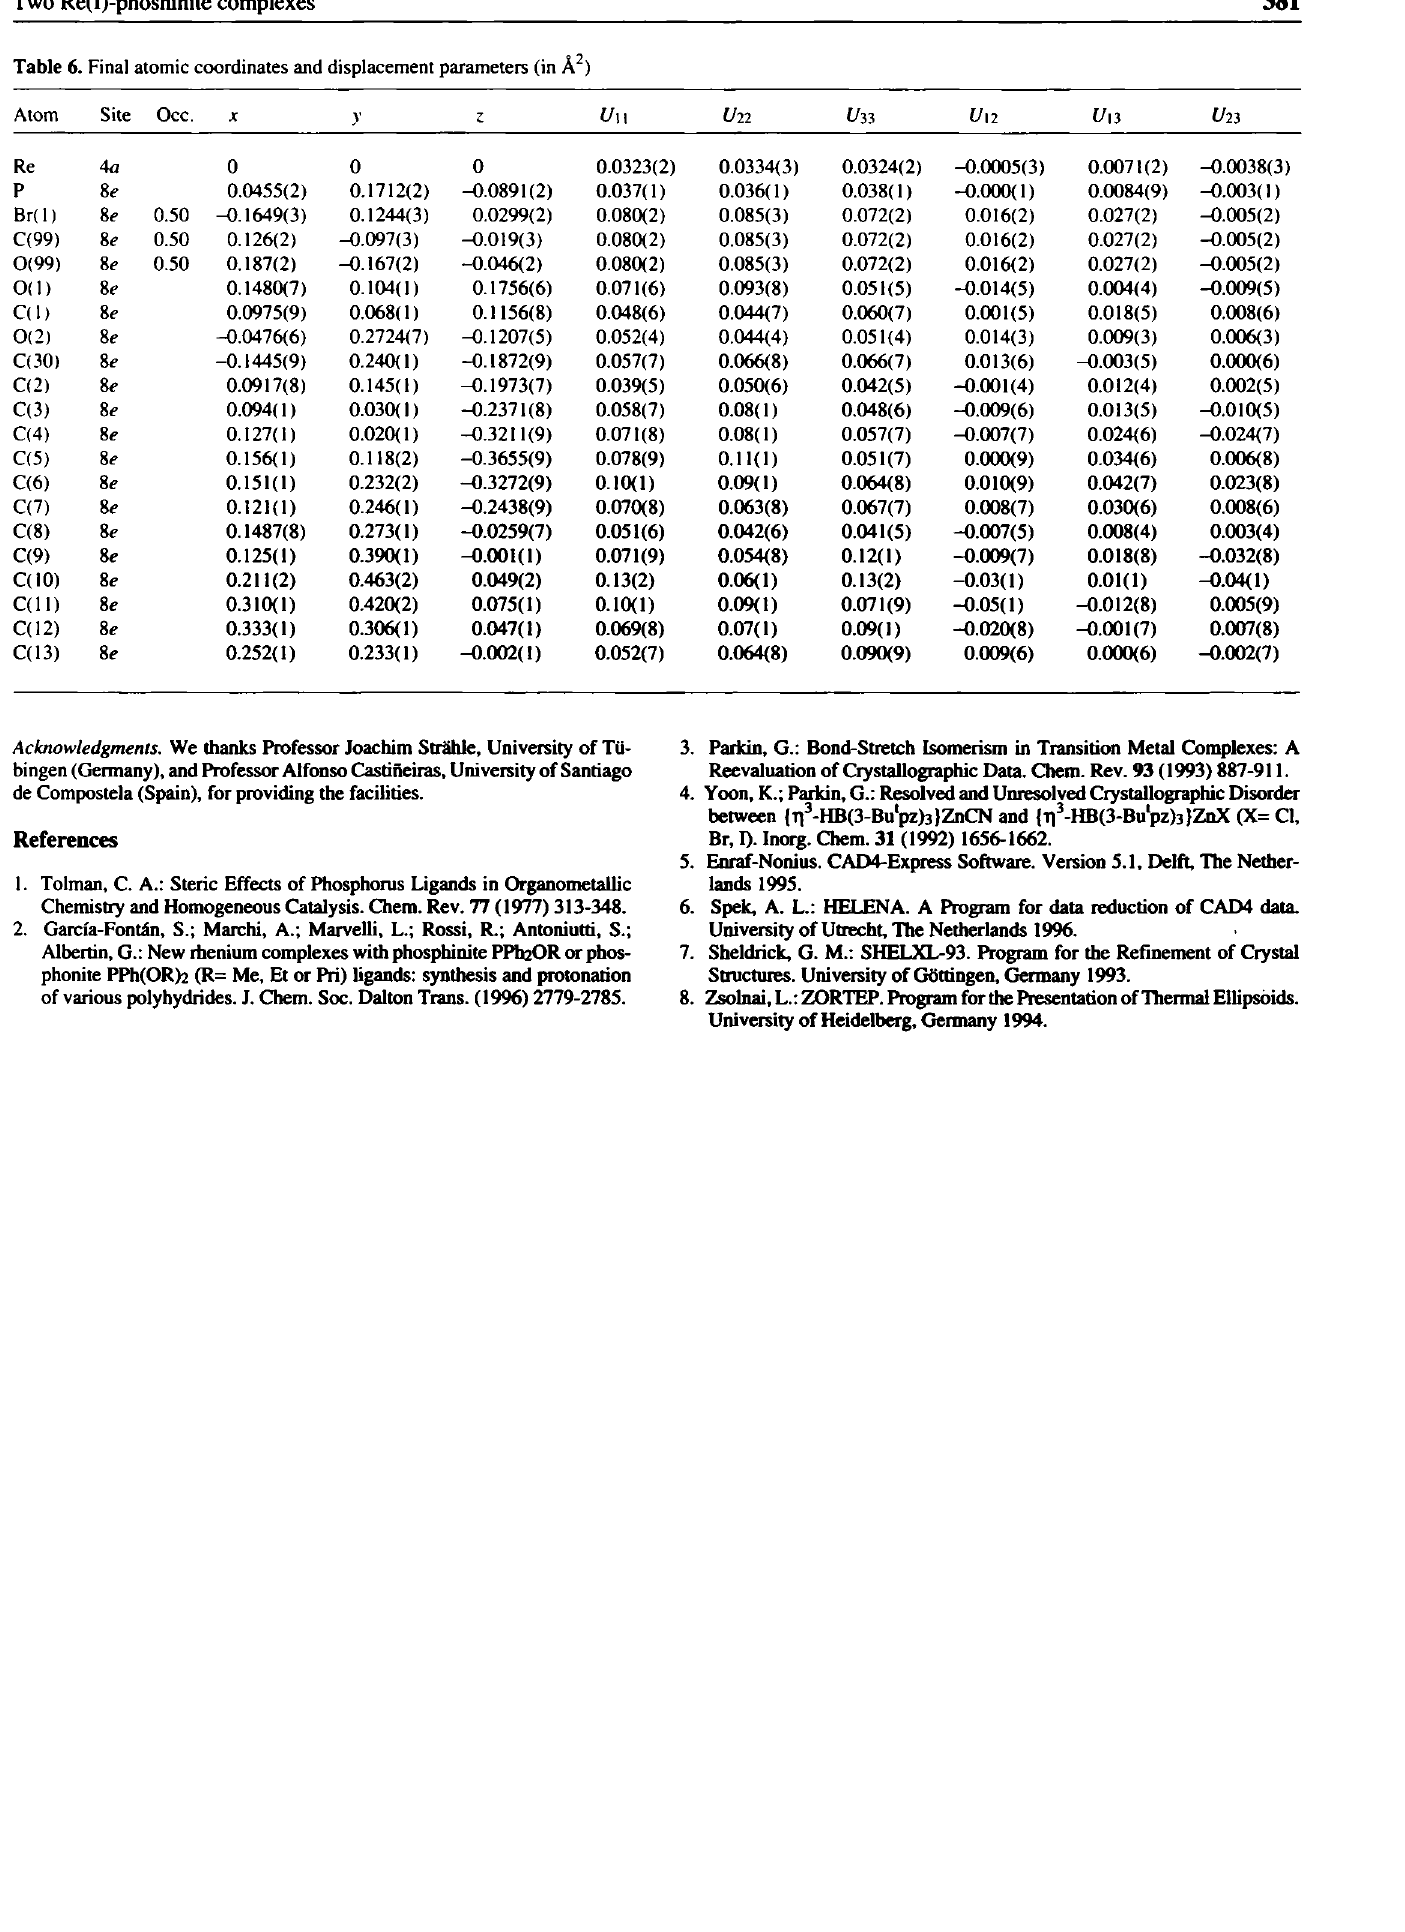
Table 6. Final atomic coordinates and displacement parameters (in Â^) Atom